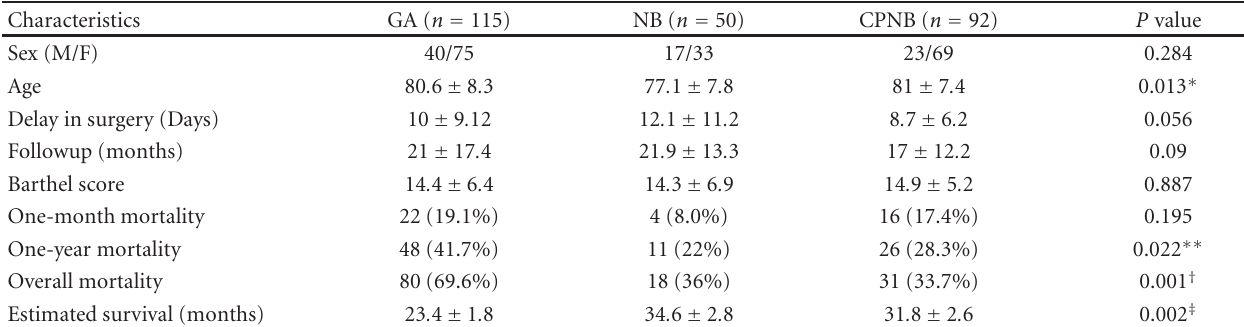
Table 1: Characteristics of the study population according to anesthesia